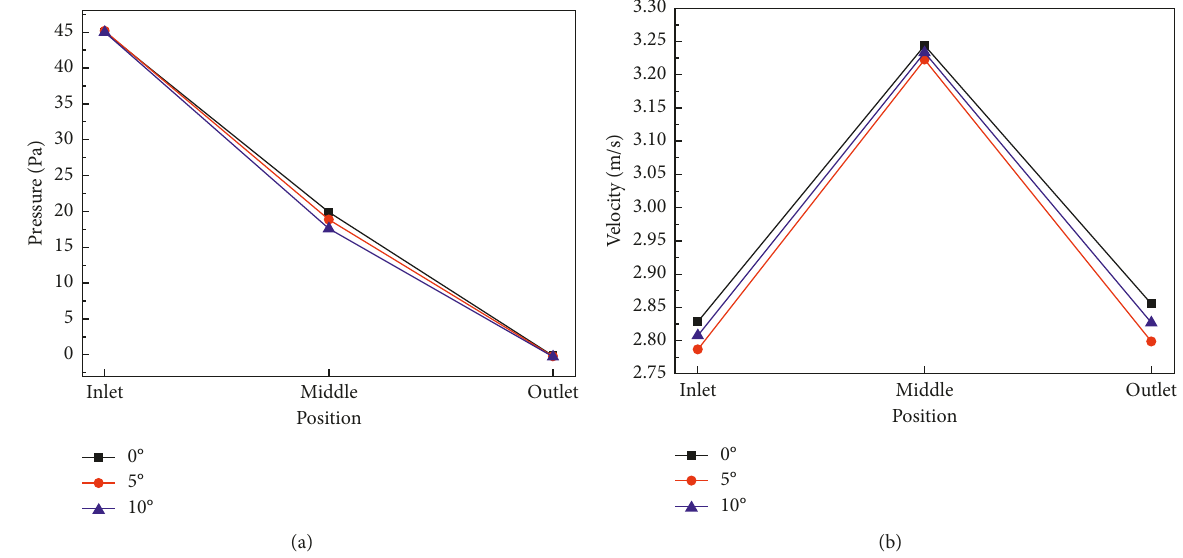
Figure 2: Variation of (a) pressure and (b) velocity for dust collector.